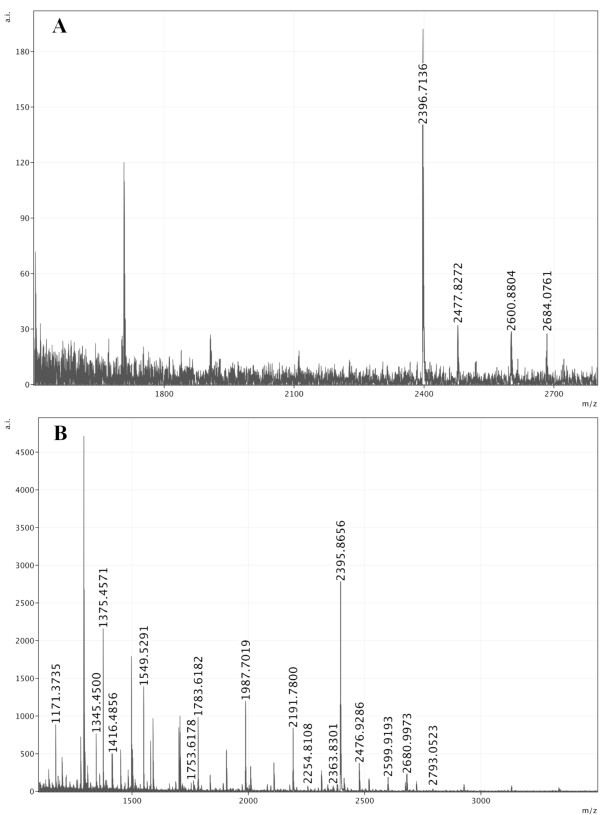
Mass spectra of N-glycans from the purified HLGP and from D. marginatus hemolymph. A) MALDI-TOF spectrum of enzymatically released N-glycans from HLGP. Four peaks corresponding to s HexNAc2Hex9 (m/z 2396.7), HexNAc2Hex10 (m/z 2600.8), HexNAc4Hex7 (m/z 2477.8), and HexNAc4Hex8 (m/z 2684) are marked. Three more peaks are visible corresponding to contaminating series of hexoses and O-glycans (not labeled). B) MALDI-TOF spectrum of enzymatically released N-glycans from D. marginatus hemolymph. A range of glycan structures was identified, namely high-mannose type glycans HexNAc2Hex3 to HexNAc2Hex10 (m/z 1171.3, 1375.4, 1783.6, 1987.7, 2191.8, 2395.9, 2599.9) and complex fucosylated and non-fucosylated glycans such as HexNac3Hex3 (m/z 1416.5), HexNAc2Hex4dHex1 (m/z 1549.5), HexNAc2Hex5dHex1 (m/z 1753.6). Again, contaminants were present in the sample - series of hexoses as well as O-glycans (not labeled).